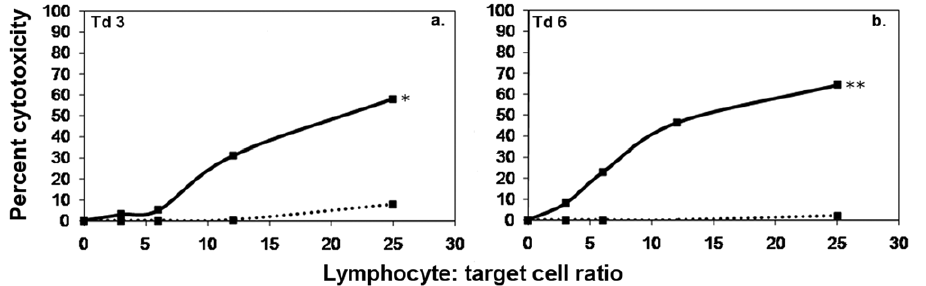
Figure 3. Cytotoxic responses of nylon wool non adherent cells from K562 immunised Tasmanian devils. 51 Cr release assays were performed for 18 hr at lymphocyte: target ratios of 25:1. 12:1, 6:1 and 3:1. Solid black lines represent the responses of MNC. Dotted lines represent the responses of nylon wool non adherent cells. Cytotoxicity responses were absent in preparations of nylon wool filtered cells. The difference between nylon wool non adherent cells and mononuclear cell responses was statistically significant (F test; * p , 0.05, ** p , 0.0005).